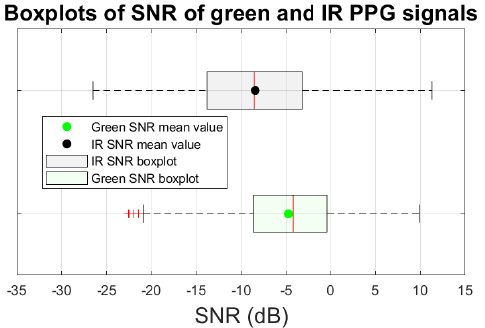
Figure 2. SNR values of IR and green PPG signals, respectively, calculated from all fourteen (14) participants. The dots represent the mean value of SNR. The red bars represent the median value of SNR. The red ‘+’ signs represent